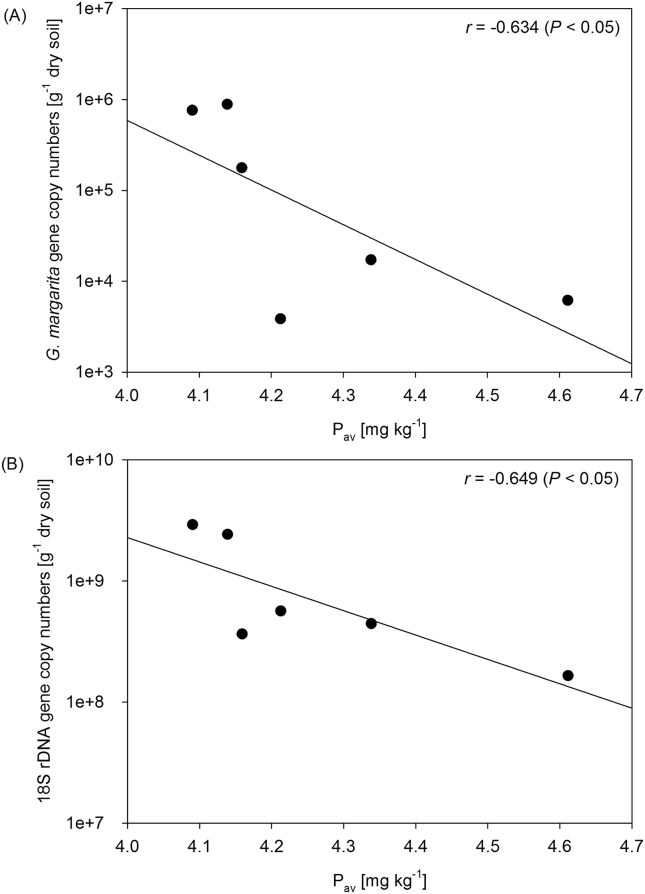
Relationship between plant-available phosphorus (Pav) content and G. margarita (A) and 18S rDNA (B) gene copy numbers. Pearson's linear correlation coefficients (r) and P values are given in each plot.